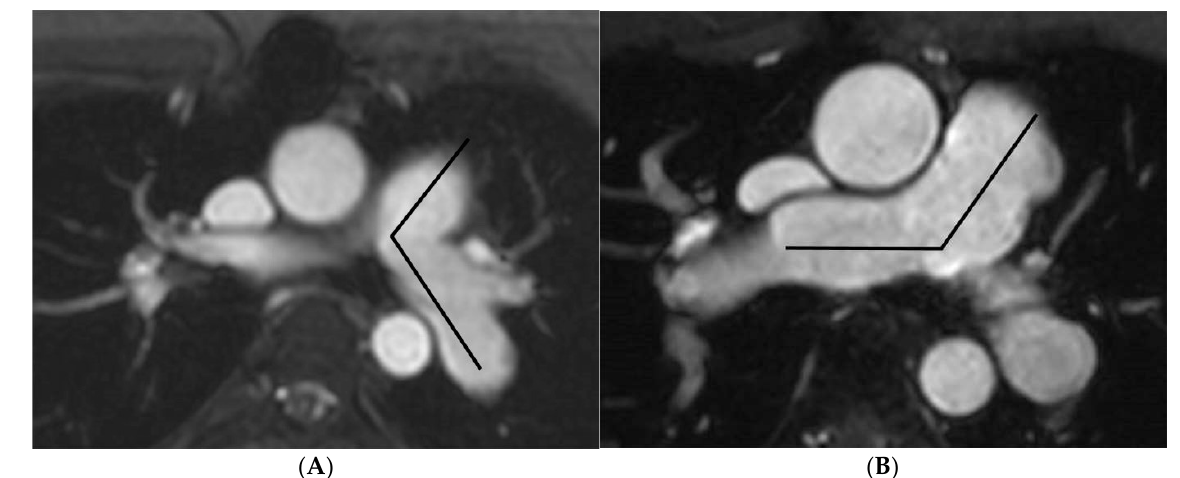
Figure 2. Contrast-enhanced magnetic resonance angiography in axial plane demonstrates measurement of the angle of left pulmonary artery ( A ) and right pulmonary artery ( B ).